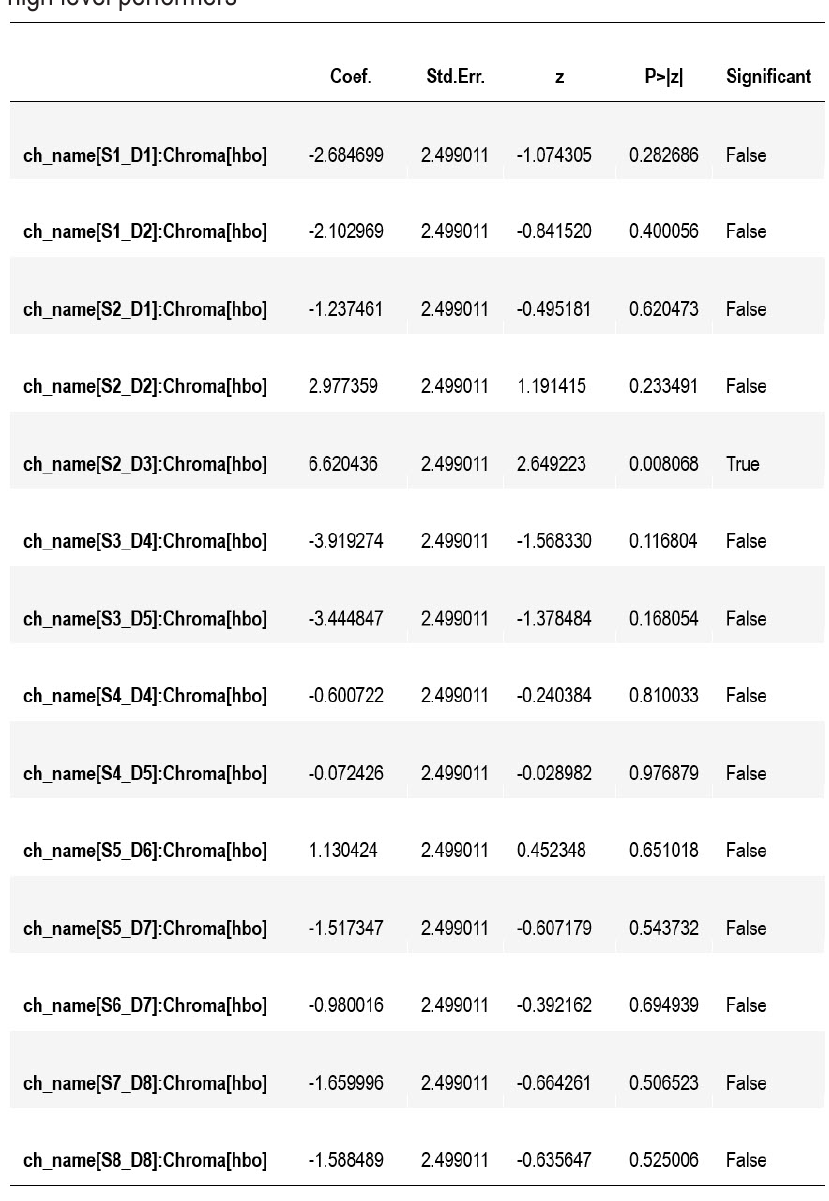
Beta coefficients of second level of GLM contrast “reading task versus a numerical format of calculation” in high level